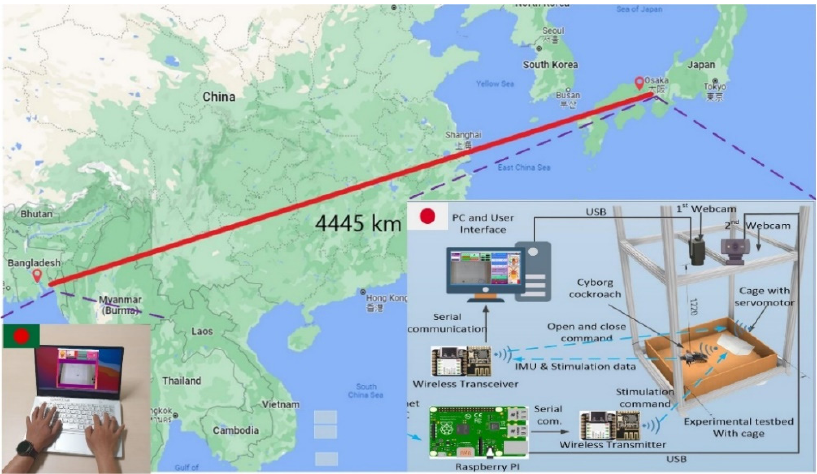
Figure 1. Proposed overall system for the teleoperated biobot between Japan and Bangladesh.